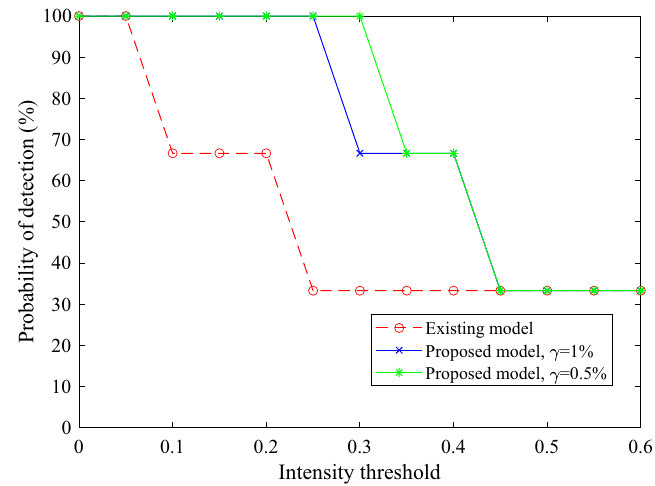
Fig. 13 Probability of detection for three unknown